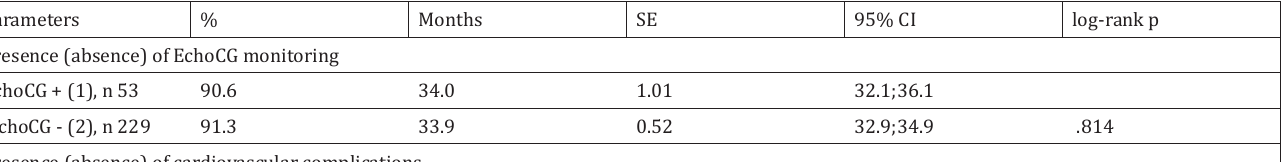
Kaplan-Meier survival curves indices for the presence of EchoCG monitoring, the presence of recorded CV events, and the quality of chemotherapy courses.